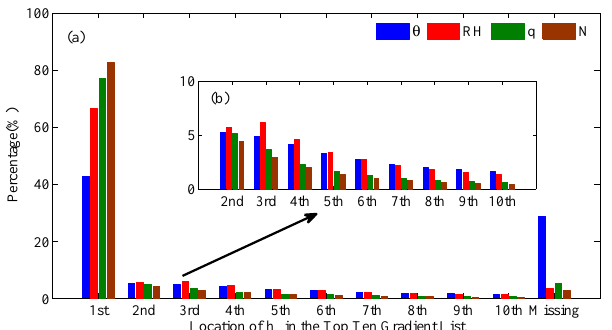
Figure 4. The statistical result of the consistency between h 0 ( h 0 which integrates the information of θ , RH, q and N) and the four existing methods at the 79 North America stations. Percentage in “1st” means the h 0 coincides with the existing method. The missing value means the case of the h 0 did not exist in the top 10 gradient lists for the specific variable and the h 0 is determined by the other three standards. The subgraph (b) shows a close-up view of the 2nd to 10th in (a)